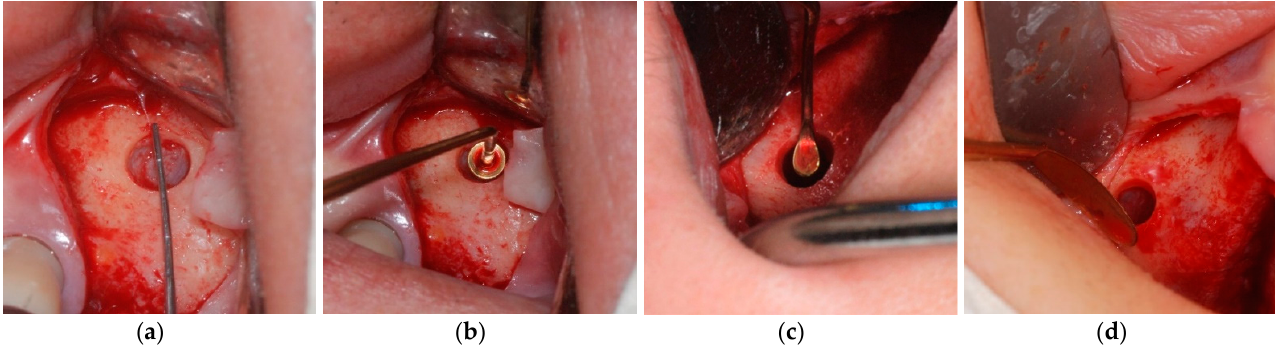
Figure 3. ( a ) Schneiderian membrane observed through a minimum-sized lateral window with a diameter of 5 mm; ( b ) Membrane detachment using a dome-shaped sinus elevation instrument; ( c ) Membrane elevation using a blunt-edged sinus elevation instrument; ( d ) Elevated membrane is visible with a long shank blunt-edged sinus elevation instrument.